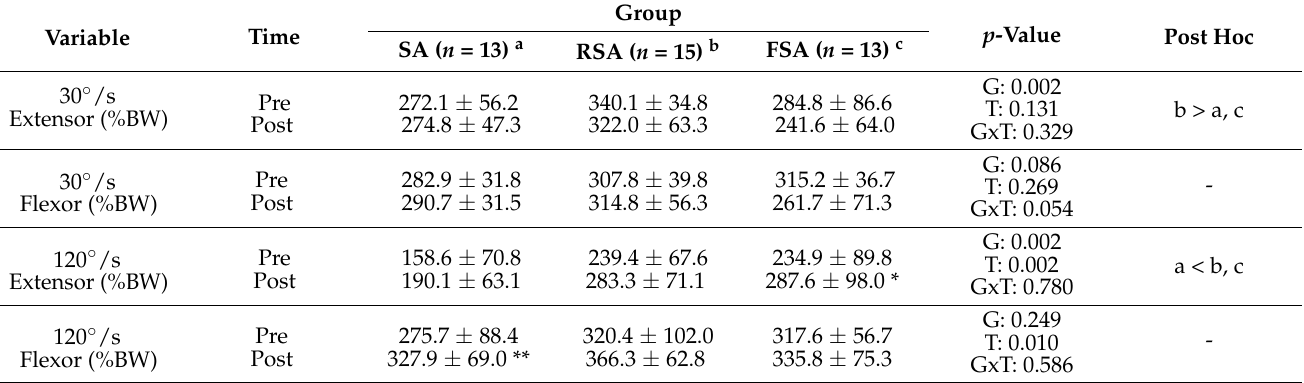
Table 3. Measurements of isokinetic muscle function of trunk parameters by group and time.